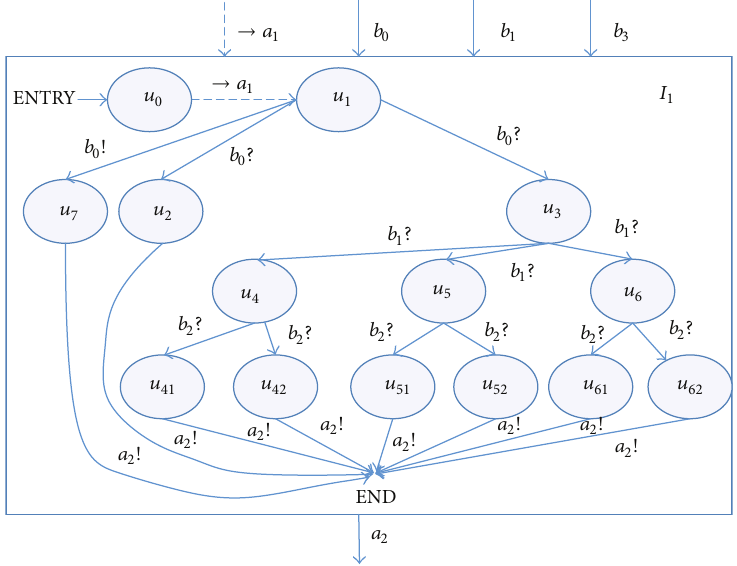
Figure 8: Input automata 𝐼 1 of the aircraft braking